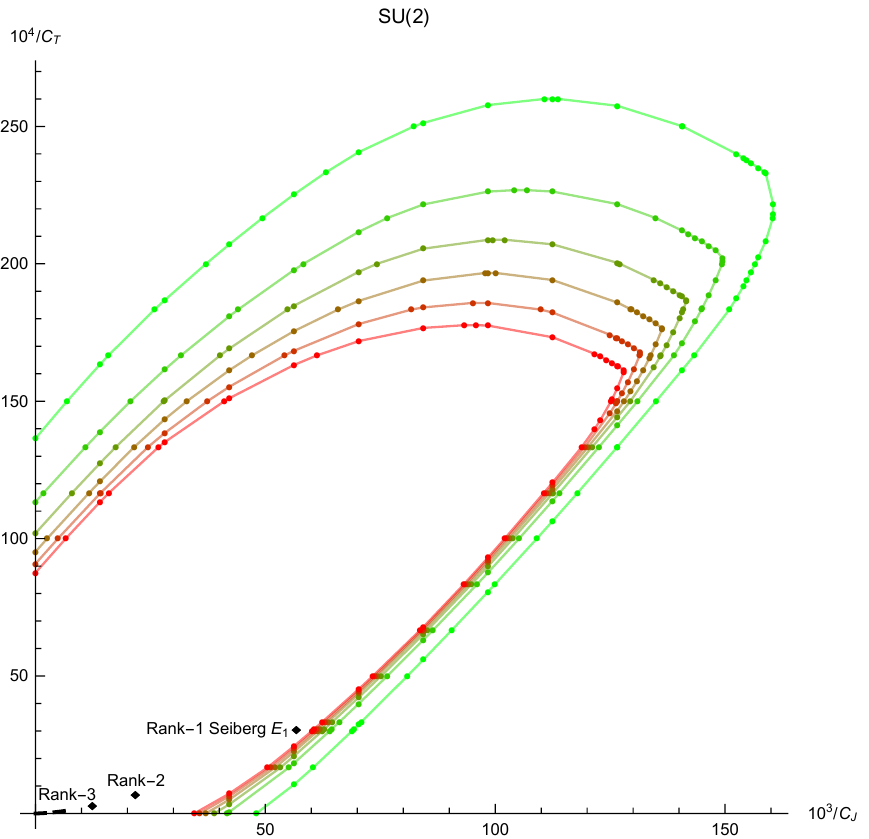
Figure 4. Allowed region in the C T (cid:0) C J plane for interacting theories with SU(2) (cid:13)avor group, at derivative orders (cid:3) = 20 ; 24 ; : : : ; 40, shown from green to red. Also shown are the four-instanton values in the rank-one Seiberg E 1 theory, the perturbative values in the rank-two and three, and the values according to the large-rank formula (dashed line).